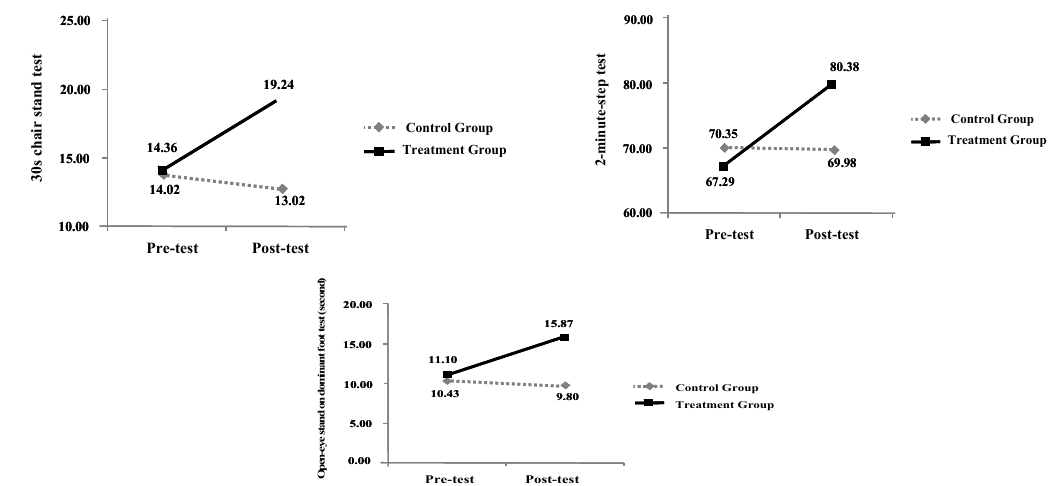
Figure 2. Intraclass Regression Analysis of Biomarkers.